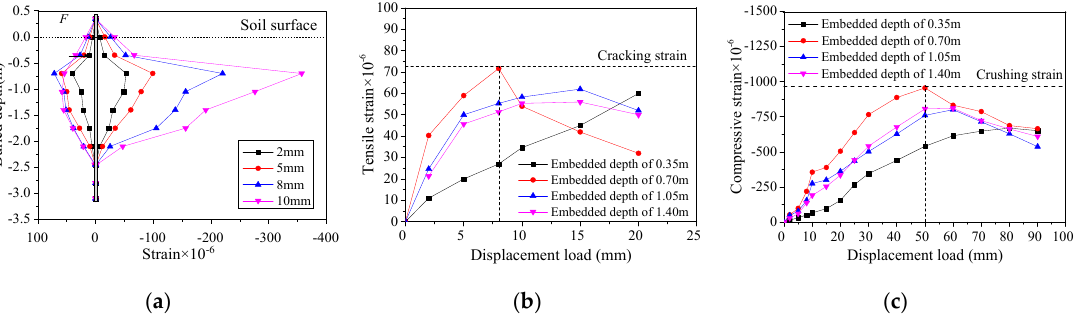
Figure 12. Strain distribution of RP-4 specimen. ( a ) Compressive and tensile strain distributions. ( b ) Tensile strain versus loading history. ( c ) Compressive strain versus loading history.